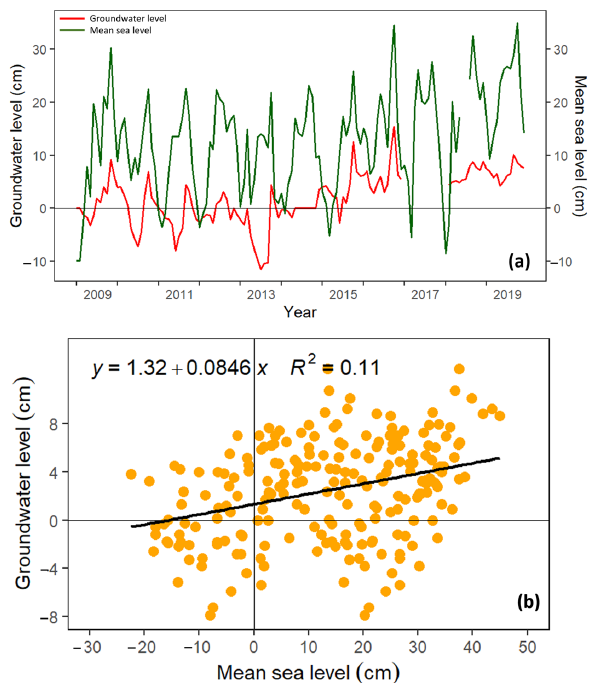
Figure 5. Panel ( a ) is the time series of groundwater table depth (GWT) and mean sea level using monthly data from 2009–2019, while panel ( b ) is the linear relationship between GWT and mean sea level.